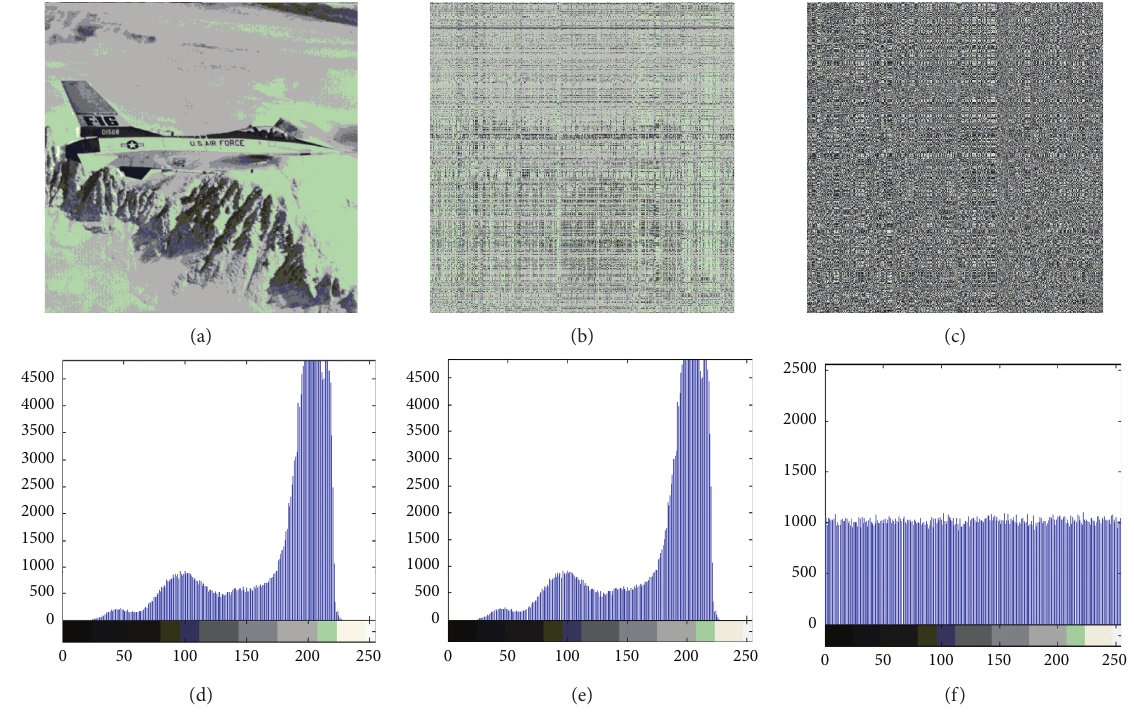
Figure 4: The histogram of the image